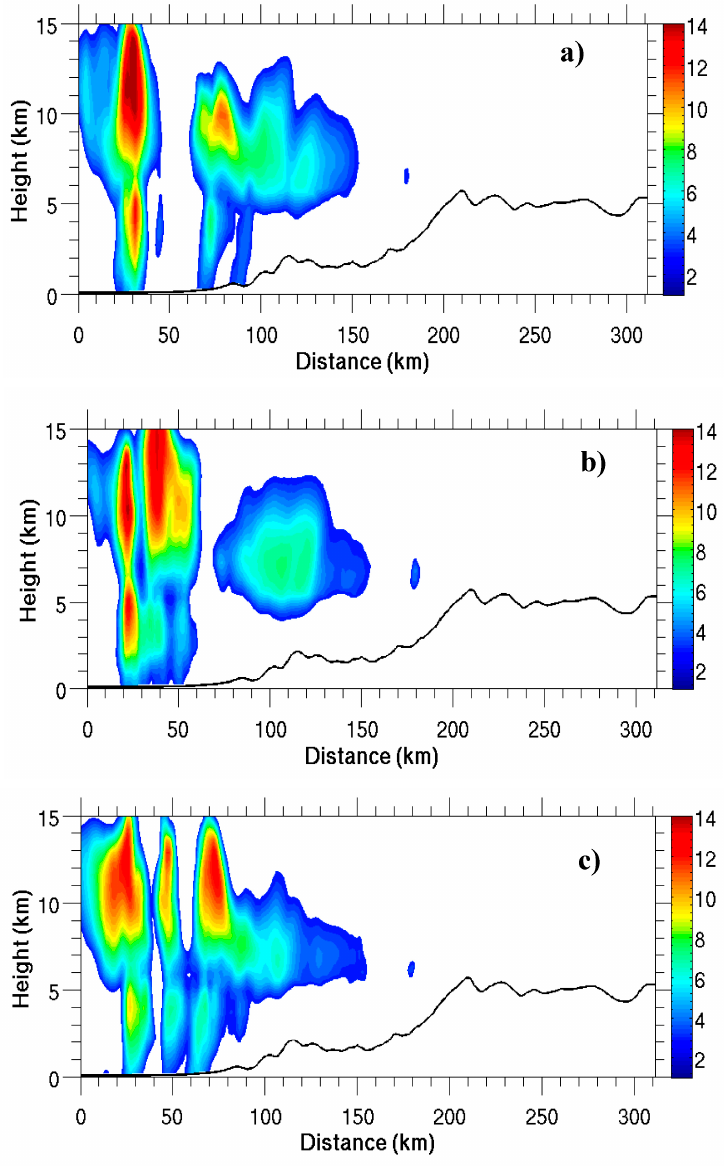
Figure 8. Distribution of total condensate (g kg − 1 ) along line AB in the Figure 5a for ( a ) ‘low’; ( b ) ‘medium’; and ( c ) ‘high’ aerosol concentration simulated for the Tctrl simulation. These cross-sections were taken at 4:45 GMT (10:30 am local time), just before onset of the